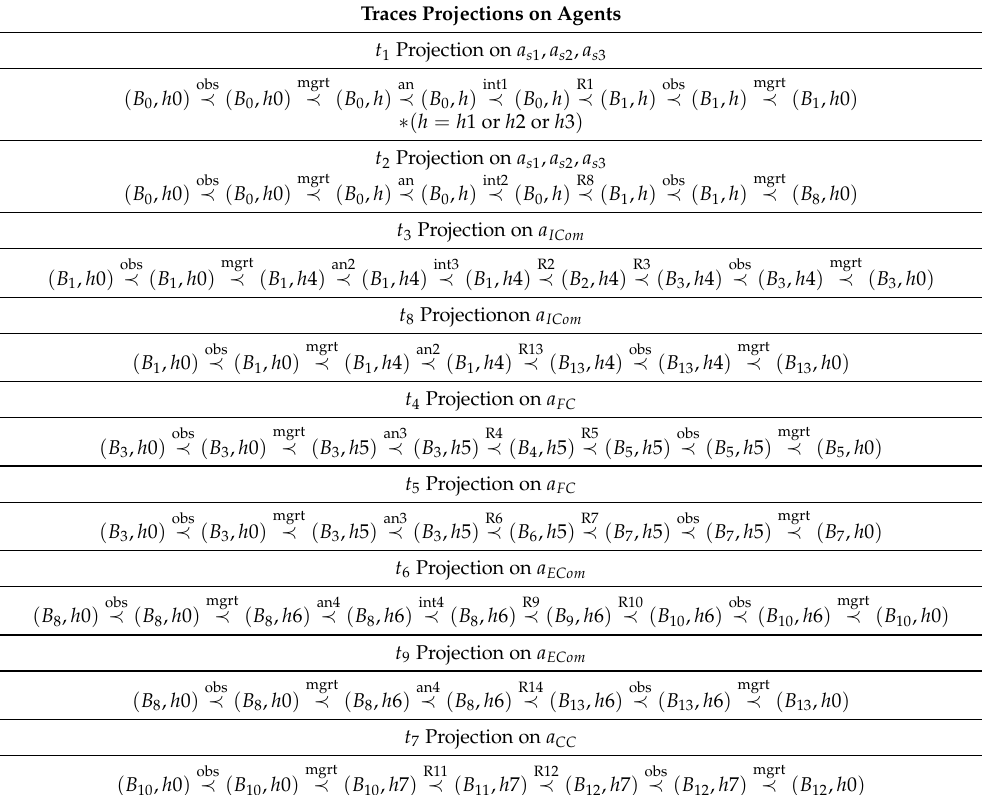
Table 7. Traces projections